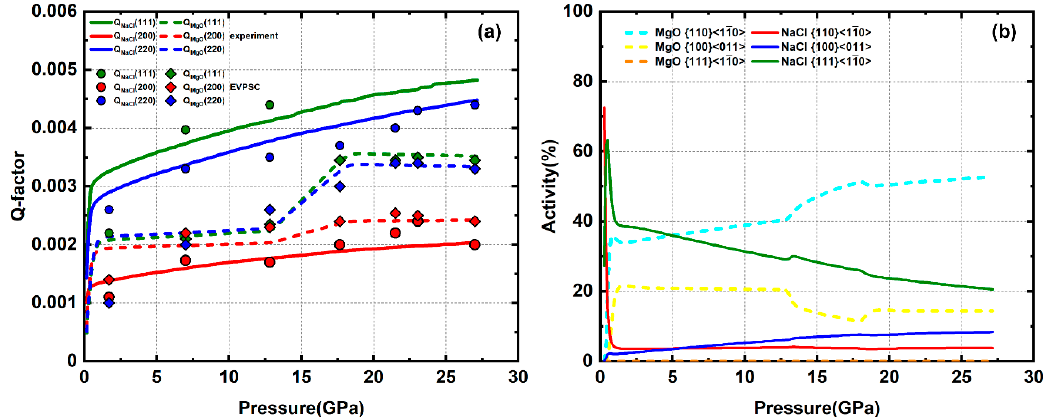
Figure 12. ( a ) Experimental and modeled Q-factors of 80% MgO + 20% NaCl. ( b ) slip system activity of MgO and NaCl.